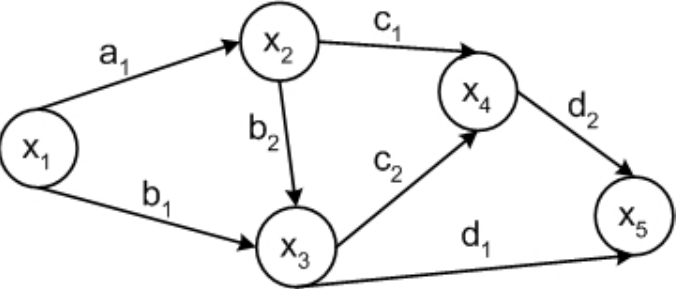
Figure 2. Bayesian network of factors influencing on labor productivity. Network variable no- tation: x 1 —tested program M1, . . . , M3; x 2 —social capital (an index); x 3 —motiation (an index); x 4 —innovativeness (an index); x 5 —individual labor